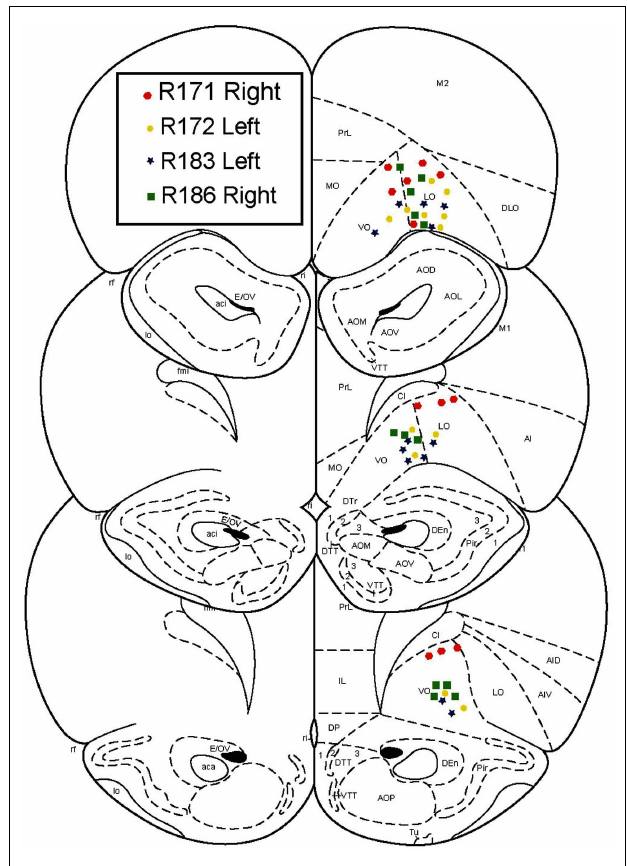
FIGURE 2 | Histology. All recordings were confirmed to be in orbitofrontal